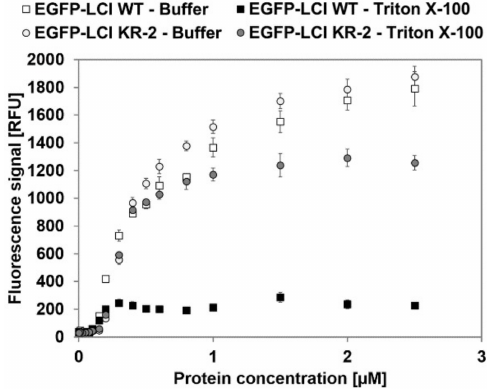
Figure 4. Determination of EGFP-LCI WT and EGFP-LCI KR-2 equilibrium dissociation constant K D and maximal binding capacity B Max . The binding saturation of EGFP-LCI WT and EGFP-LCI KR-2 was determined in a PP-MTP well (contact area 35 mm 2 ) after 3 cycles of washing with Tris/HCl buffer (pH 8.0, 50 mM) and elution with either Tris/HCl buffer (pH 8.0, 50 mM) or Triton X-100 (pH 8.0, 1 mM). Open square: EGFP-LCI WT eluted with buffer; black square: EGFP-LCI WT eluted with Triton X-100; open dot: EGFP-LCI KR-2 eluted with buffer; and grey dot: EGFP-LCI KR-2 eluted with Triton X-100 (pH 8.0, 1 mM).